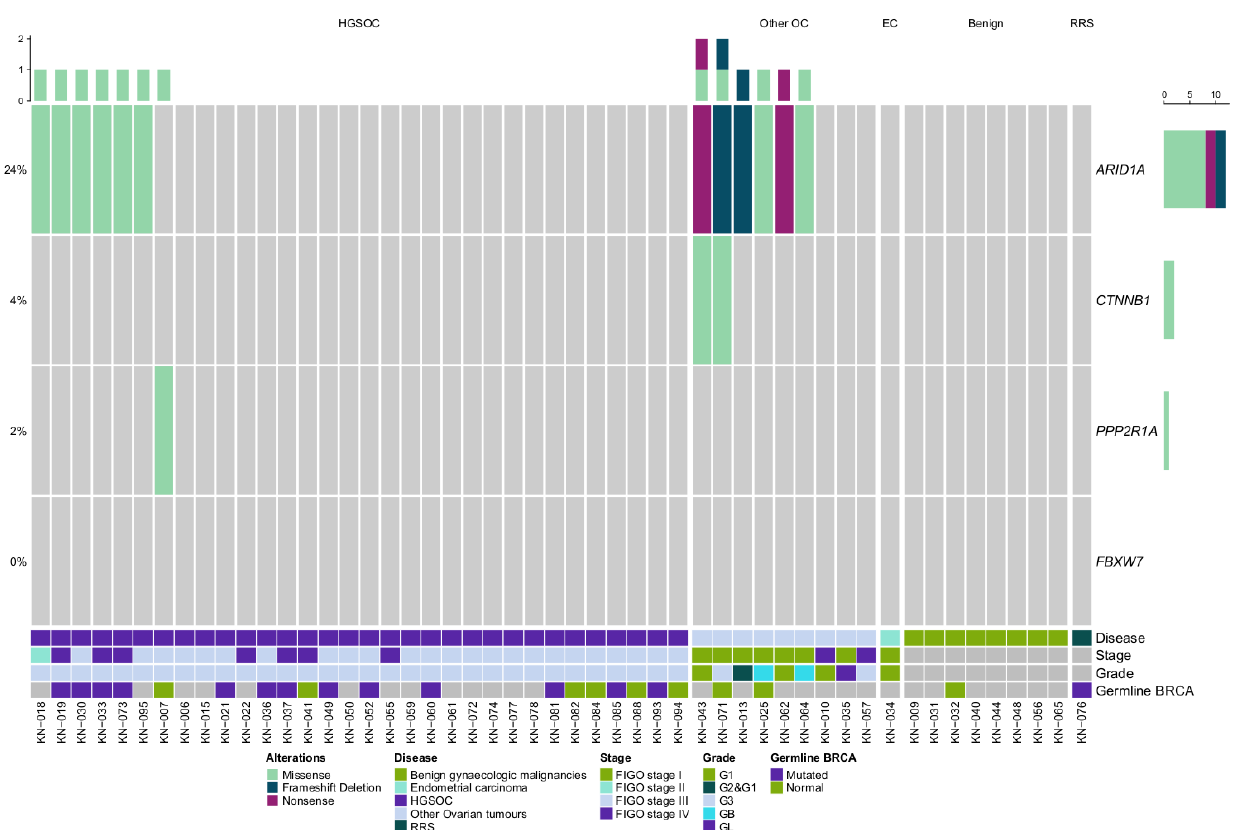
Figure 4. ROC curve analysis of tissue mRNA biomarkers. ( A ) gynaecologic cancer (ovarian can- cers + one endometrial case) vs. benign cases. ( B ) HGSOC cases vs. other gynaecologic cancer cases. AUC—area under the curve.